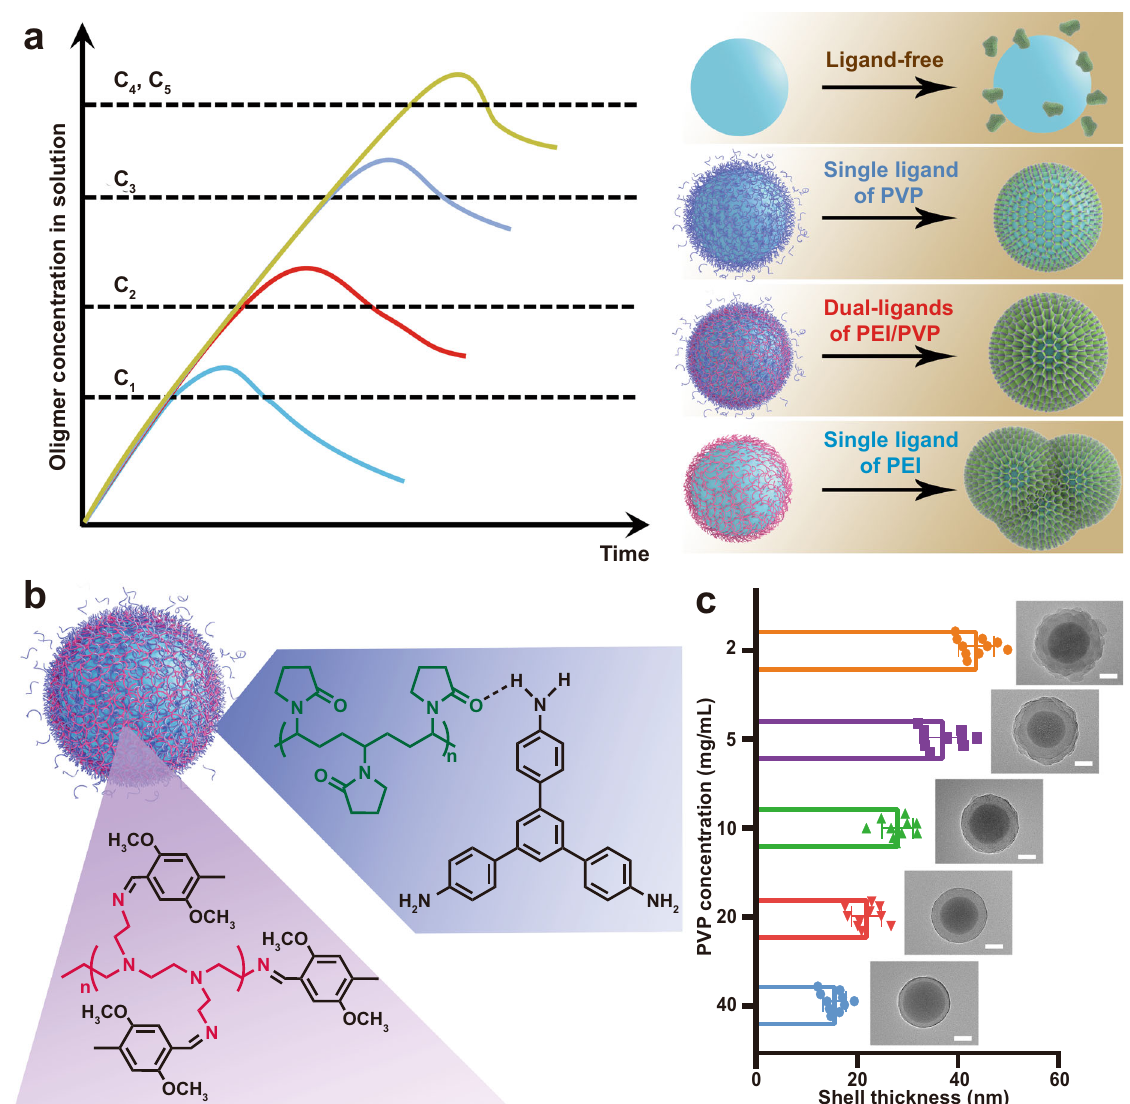
Fig. 6 The mechanism of the dual-ligand assistant strategy. a The schematic illustration of the oligomers concentration in the solution for the formation of the COF shell varied with the reaction time in the presence of the nanoparticles with different ligands (PVP, PEI and PVP, and PEI) based on LaMer model. C 1 , C 2 , and C 3 are the critical heterogeneous nucleation concentrations of polyimine oligomers on PEI-modi fi ed SiO 2 nanoparticles, PEI and PVP co-modi fi ed SiO 2 nanoparticles, and PVP modi fi ed SiO 2 nanoparticles, respectively. C 4 and C 5 represent the critical homogeneous and heterogeneous nucleation concentrations of polyimine oligomers on bare SiO 2 nanoparticles. b The schematic illustration of the interaction between the dual ligands and monomers. c The relationship between PVP concentration and shell thickness of the core@shell SiO 2 @COF nanoparticles by dual ligands assistant strategy. Scale bars are 50 nm. Data in ( c ) are presented as mean ± s.d. derived from n = 10 independent particles. Source data underlying ( c ) are provided as a Source Data fi